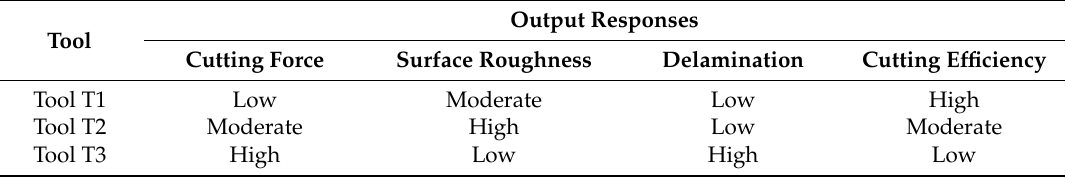
Table 6. Consolidated results.